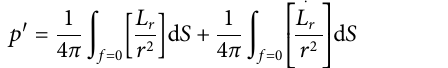
Frontiers in Energy Research |